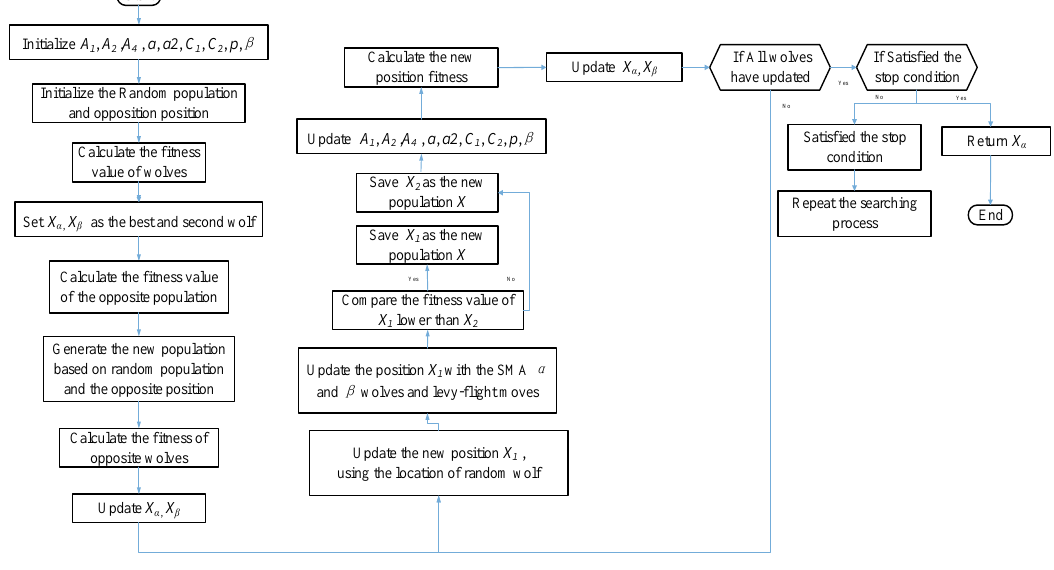
Figure 1. Flowchart of SLEGWO.